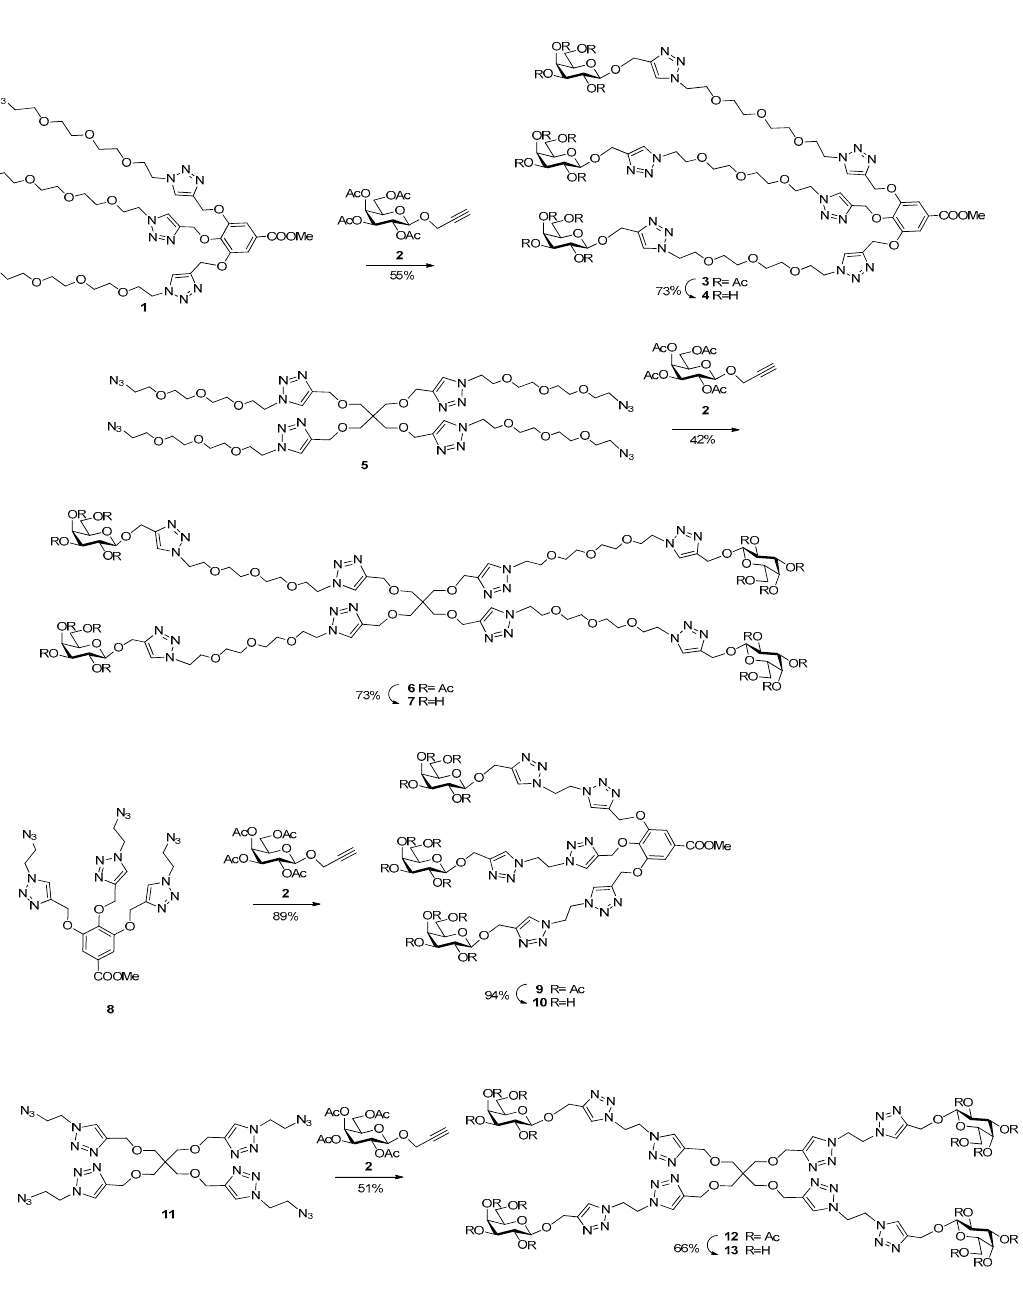
Figure 1. The tetravalent, α - L -fucoside-containing inhibitor with tetraethylene glycol bridges (compound 14 ) [29].